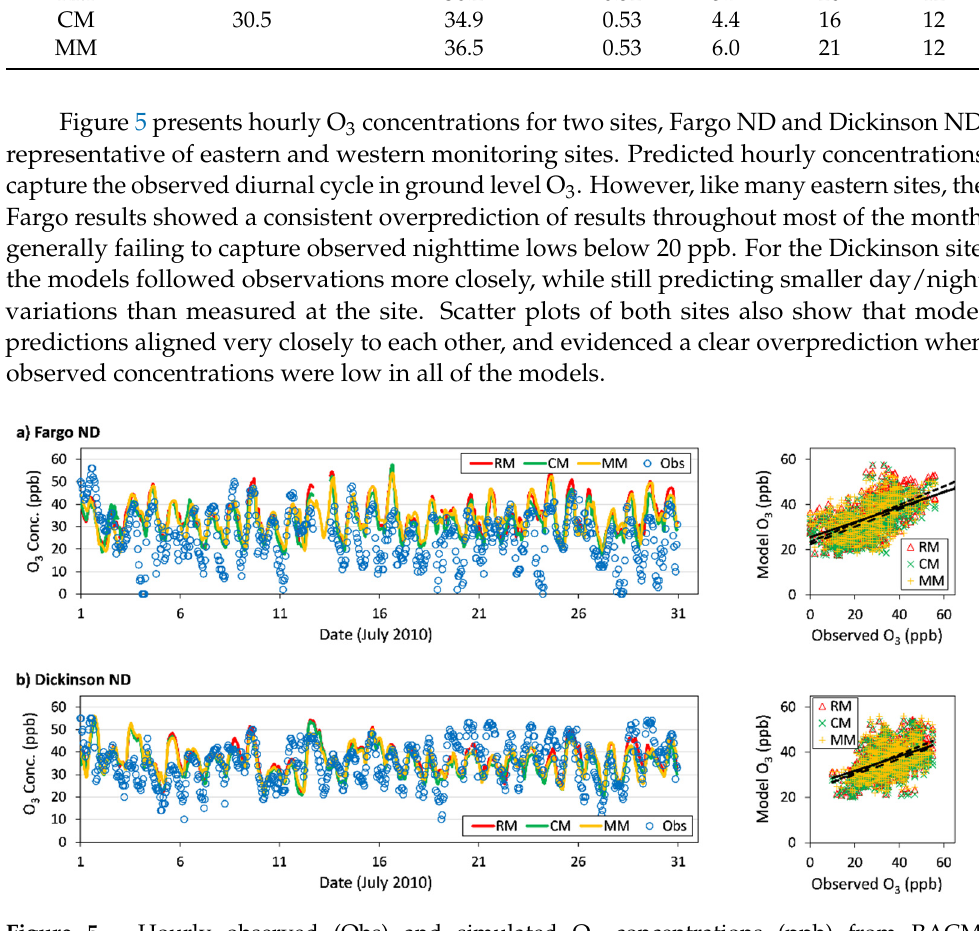
Figure 5. Hourly observed (Obs) and simulated O 3 concentrations (ppb) from RACM- MADE/SORGAM (RM), CBMZ-MOSAIC (CM), and MOZART-MOSAIC (MM) chemistry-aerosol mechanisms. Time series shown on left, with scatter plots of simulated vs. observed values on the right for ( a ) Fargo, ND and ( b ) Dickinson, ND.